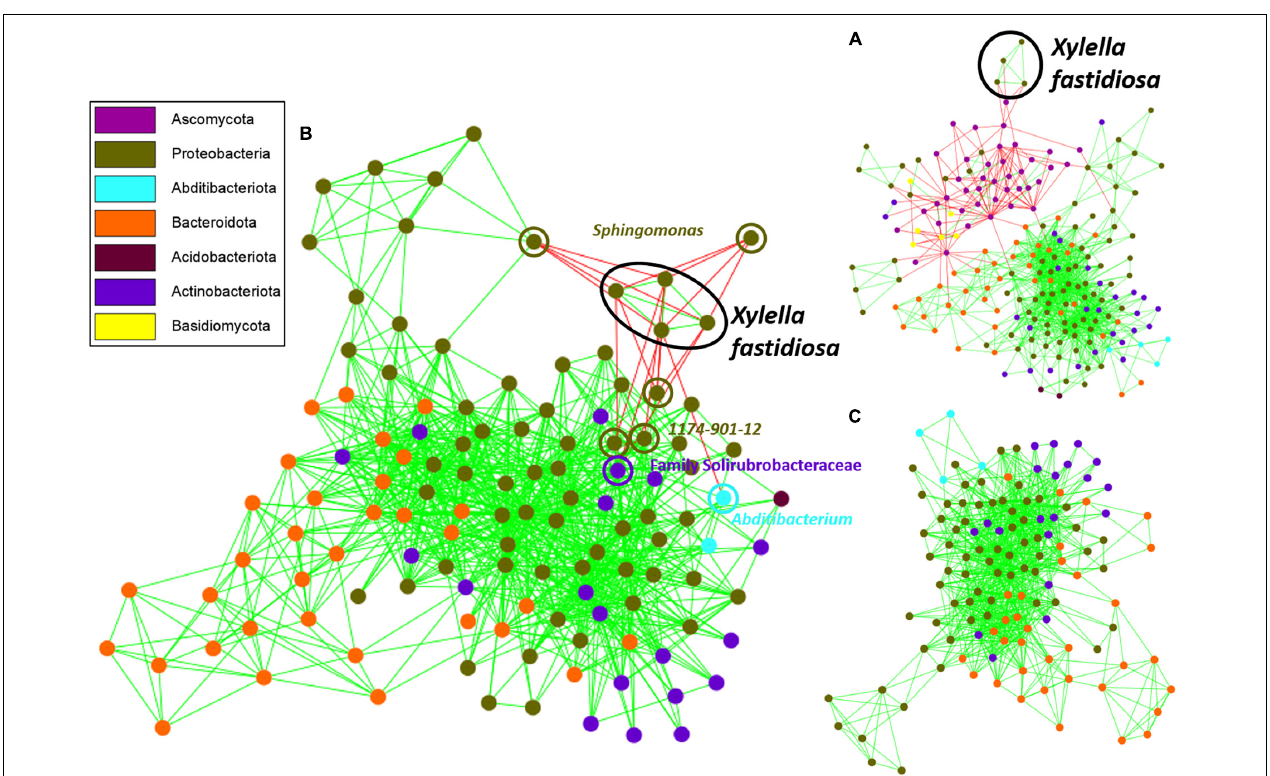
FIGURE 8 | Co-occurrence network inference plot based on the MCODE method showing highly interconnected regions of bacterial and fungal communities (A) , or bacteria present in the xylem of almond trees before (B) or after (C) the removal of Xylella fastidiosa ASVs from the data set. Nodes in blue and black represent fungal and bacterial ASVs, respectively, and pink nodes correspond to X. fastidiosa ASVs. Copresence (green) and mutual exclusion (red) are shown as the edges between the